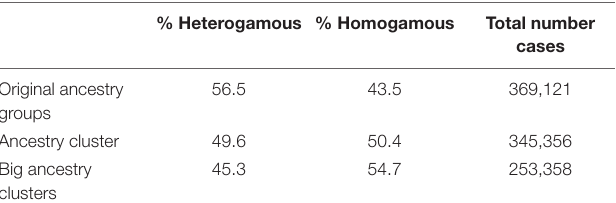
TABLE 4 | Frequency of HomHetGam, according to aggregation in